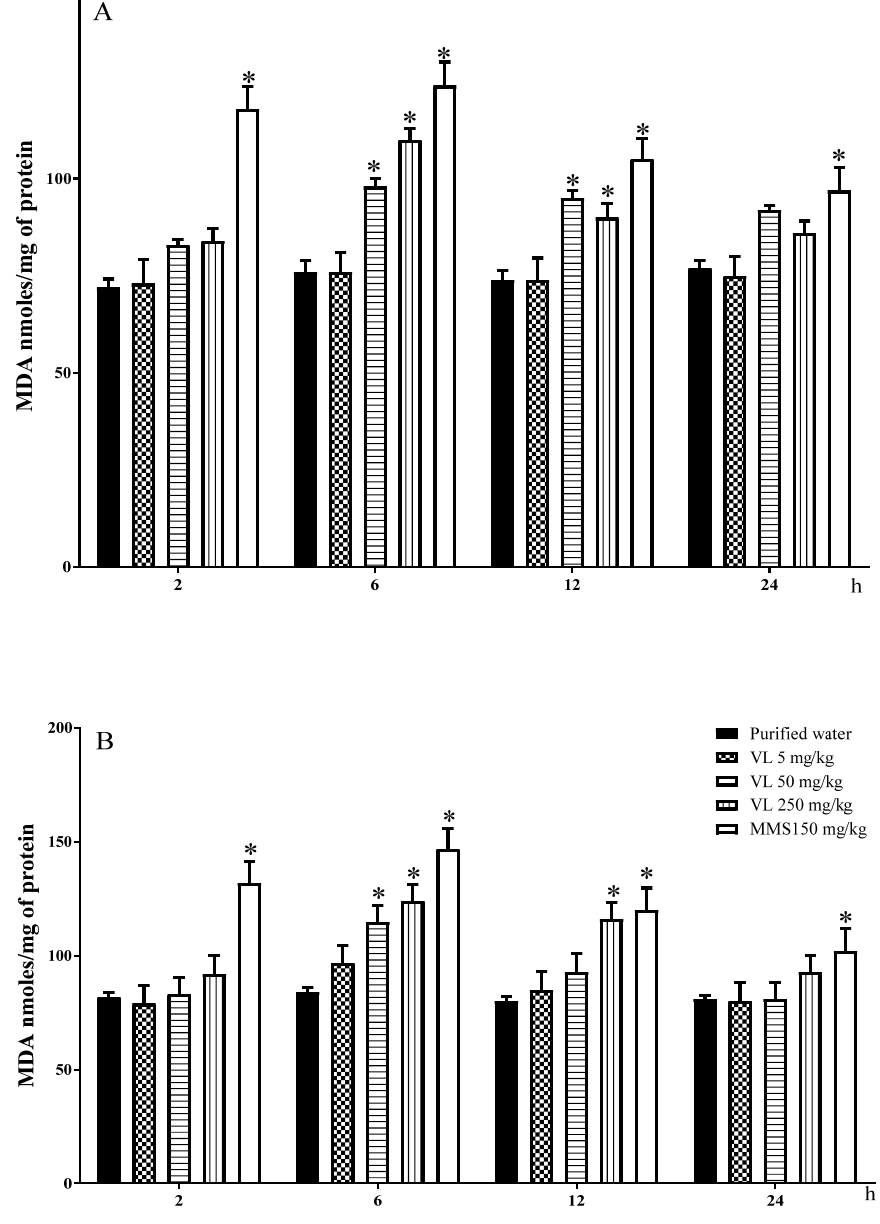
Figure 3. Lipid peroxidation induced by venlafaxine (VL) measured with the malondialdehyde content (MDA) in the brain of mouse ( A ) and in mouse hepatic tissue ( B ). MMS = methyl methane- sulfonate. Each bar represents the mean ± SDM obtained in 5 independent determinations per dose. * Shows statistically significant difference in comparison with the control level. Two-way ANOVA and Tukey tests ( p ≤ 0.05).